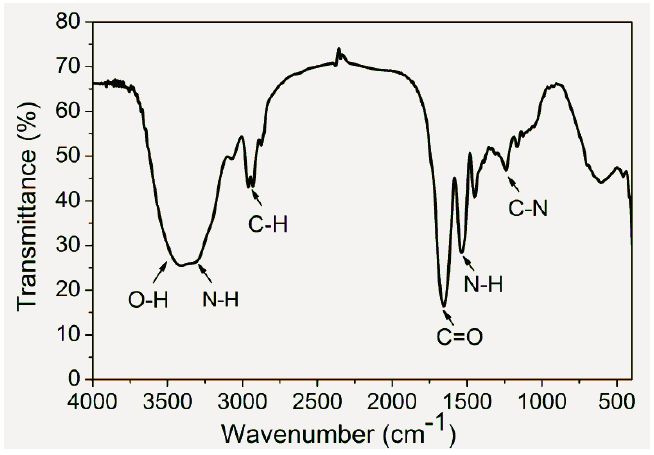
Figure 1. FTIR spectrum of zein, powder in KBr, 1 w / w %. Reprinted with permission from the PhD thesis authored by E. Corradini